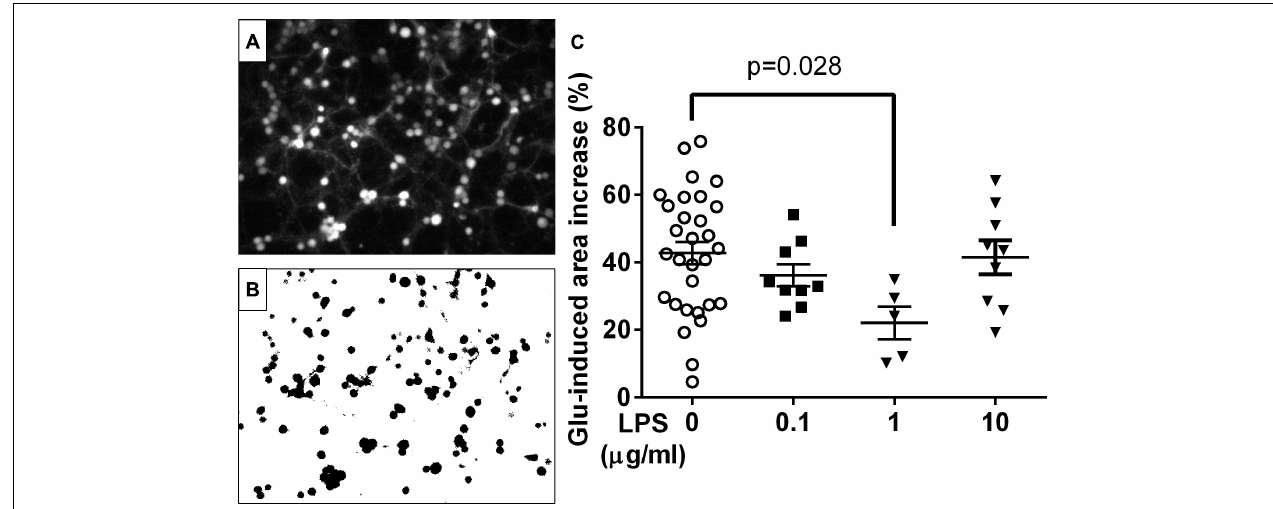
FIGURE 5 | Effect of glutamate (Glu) and LPS on the cell area in the culture of cerebellar granular neurons. (A) Typical fluorescent image of cells loaded with Fura-PE3 (excitation: 380 nm; emission: 525 nm). (B) Contours around the fluorescent image of the cell obtained using the ImageJ program. (C) Changes in the area within cell contours caused by LPS and Glu; the area of each cell was defined as the number of pixels within the contour. Glu and LPS concentrations were 100 µ M and 1 µ g/ml; the cell culture was exposed to Glu and LPS for 15 and 25 min, respectively. Median ± interquartile range. Statistically significant differences were determined according to the Kruskal-Wallis test with Dunn’s multiple comparisons